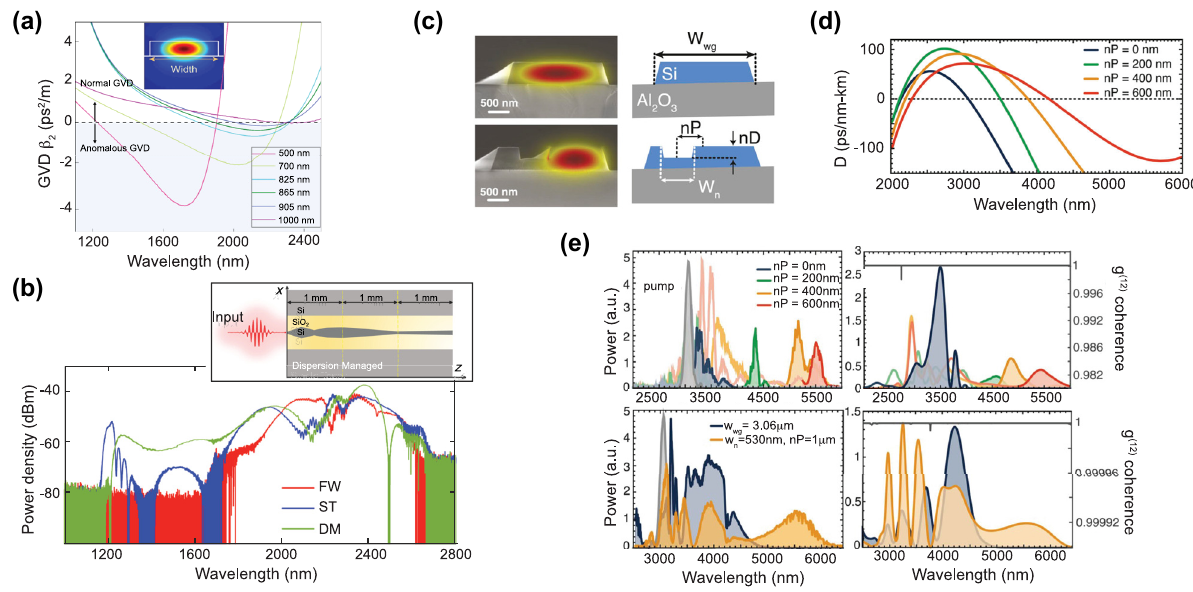
Figure 9: Advanced designs in Si platforms for SCG. (a) Computed GVD of the fundamental quasi-TE mode of 0.22 μ m thick SOI waveguides with various fixed widths, inset: fundamental transverse mode in the 0.825 μ m wide waveguide at 2200 nm. (b) Measured output spectra recorded for the dispersion managed (DM), single taper (TP), and 0.825 μ m fixed width (FW) waveguides and schematic geometry of the DM structure. (c) SEM images and cross-section diagram of strip and notch SOS waveguides. (d) Calculated GVD profiles of the notch SOS designs. (e) Measured output spectra of notch waveguides (top), and octave span broadening in a strip (blue) and notch (orange) waveguides (bottom). Experimental results are shown on the left and simulations on the right together with calculated coherence. Panels (a) and (b) adapted from [72]. Panels (c)–(e) adapted from